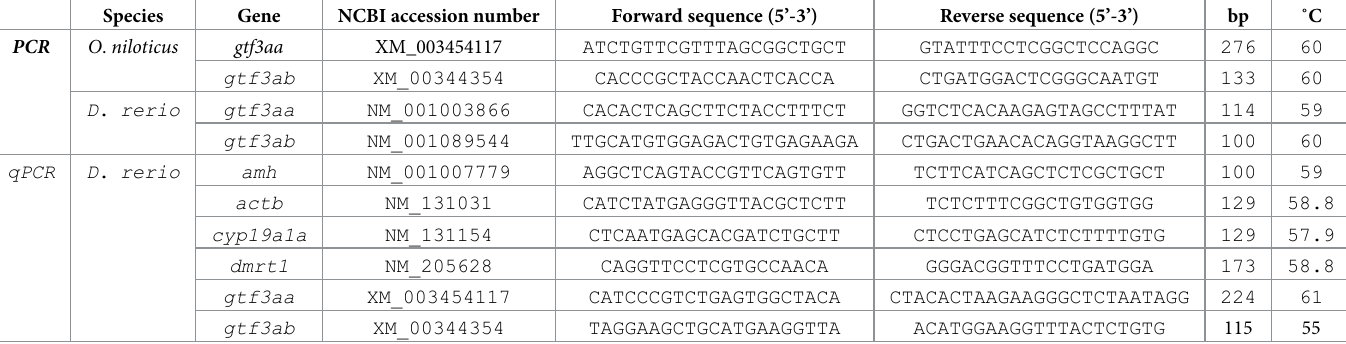
Table 1. Primer sequences used for the End-Point PCR and qPCR analysis of different target genes in zebrafish and tilapia. Amplified fragment size in bp and PCR annealing temperature (˚C) are indicated.